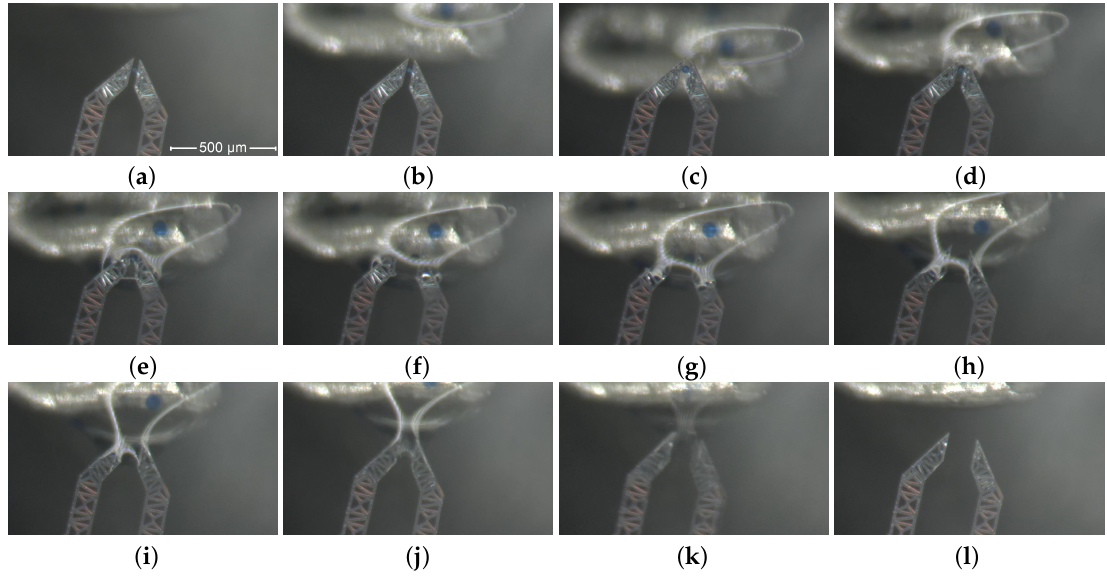
Figure 7. A complete releasing sequence: one bead hold by the jaws ( a ); progressive approaching, ( b ) and ( c ); contact with the drop and insertion ( d ) to ( e ); releasing ( f ); exit from the drop, from ( g ) to ( l